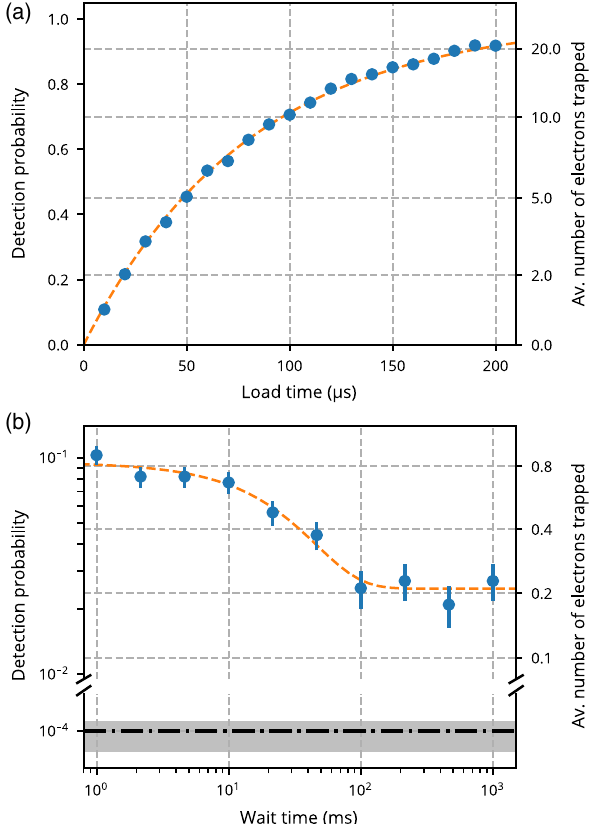
FIG. 5. Trapped electron loading and storage. (a) Electron trapping and detection probability as a function of loading time ¼ 10 μ s. The dashed curve shows an exponential fit to with t wait 1 − exp ð t= τ Þ , with τ ¼ 80 . 3 (cid:2) 0 . 5 μ s. Error bars due to 1 =e 1 =e statistical uncertainty are too small to be visible. (b) Storage time measurement with a double-exponential fit, showing three- quarters of electrons leave the trap with a decay constant τ ¼ 30 (cid:2) 7 ms, while the remaining quarter show no decay 1 =e within measurement uncertainty. The horizontal dash-dotted line displays the background detection level based on an independent measurement. Error bars and the grey band correspond to 1 s.d. statistical